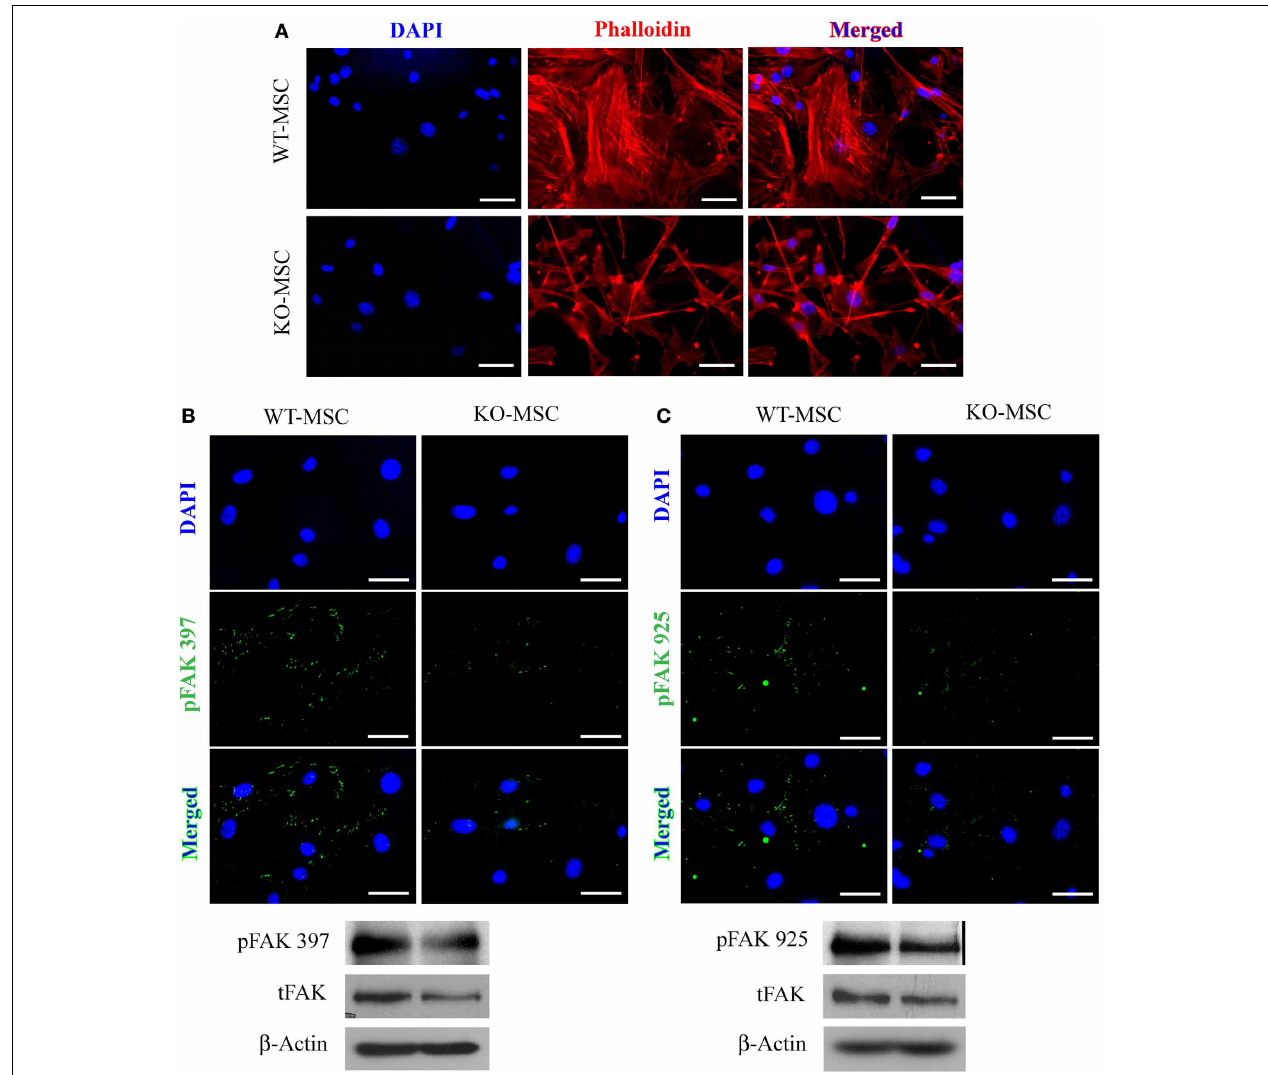
FIGURE 3 | Mesenchymal stem cell defects in CD13 KO mice are cell intrinsic. (A) phalloidin-stained MSC cells isolated from injured muscles of CD13 KO mice showed remarkable cytoskeletal disruption compared to cells from WT mice; Objective 40X (Bar = 100 μ m). (B,C) Immunofluorescent